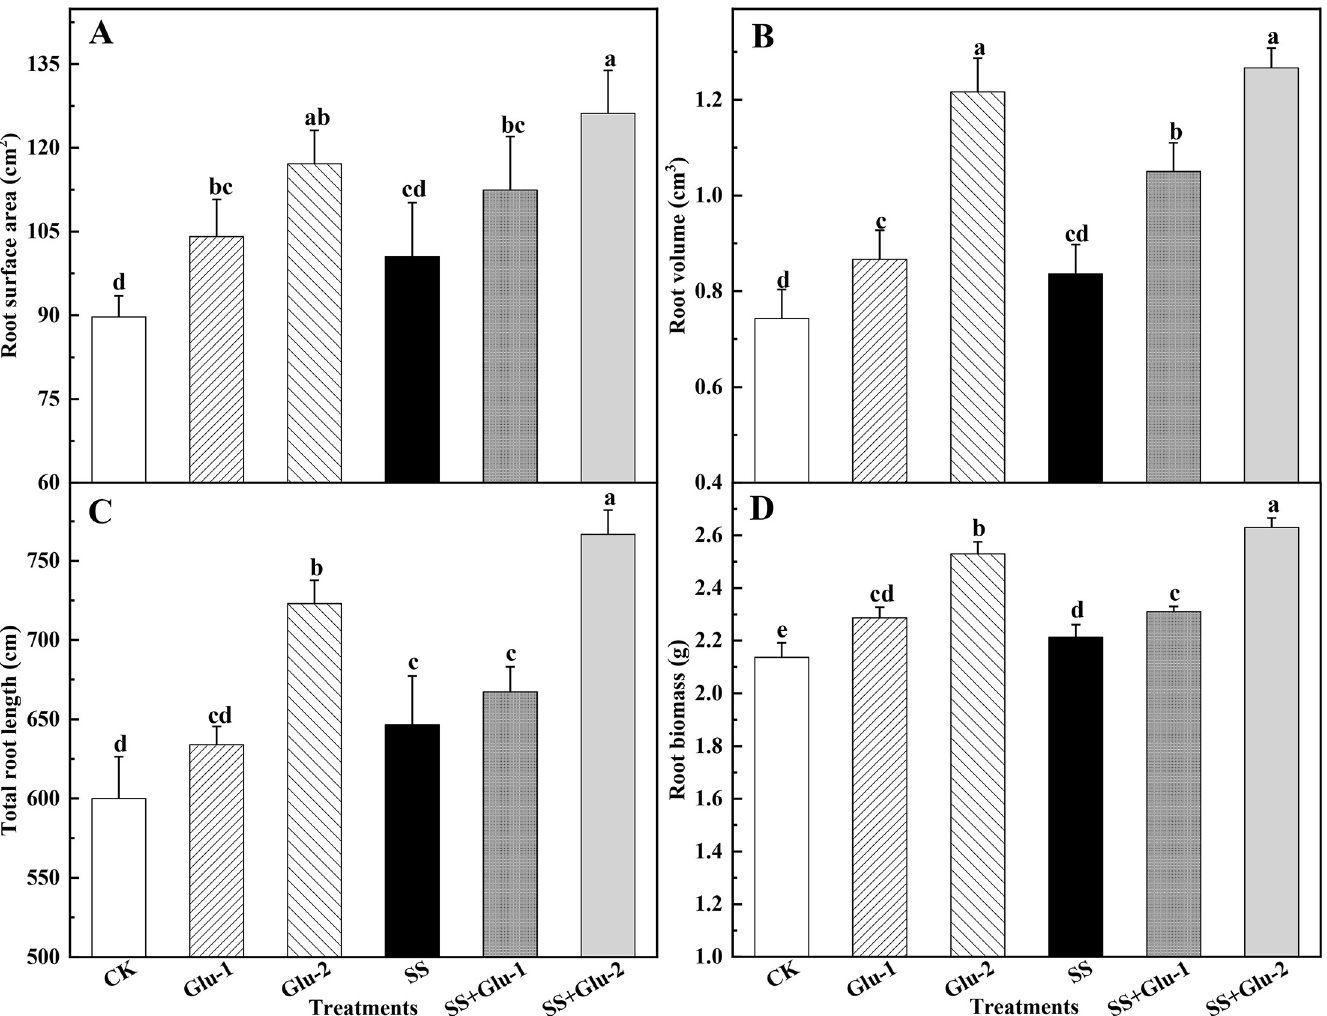
Fig 4. Root surface area (A), root volume (B), total root length (C) and root biomass (D) in the sterilized and non-sterilized soils with glucose addition at day 45. Different lowercase letters indicate significant differences between treatments ( P < 0.05). CK, non-sterilized soil without glucose addition; Glu-1, non-sterilized soil with low level of glucose addition; Glu-2, non-sterilized soil with high level of glucose addition; SS, sterilized soil without glucose addition; SS+Glu-1, sterilized soil with low level of glucose; SS+Glu-2, sterilized soil sterilization with high level of glucose